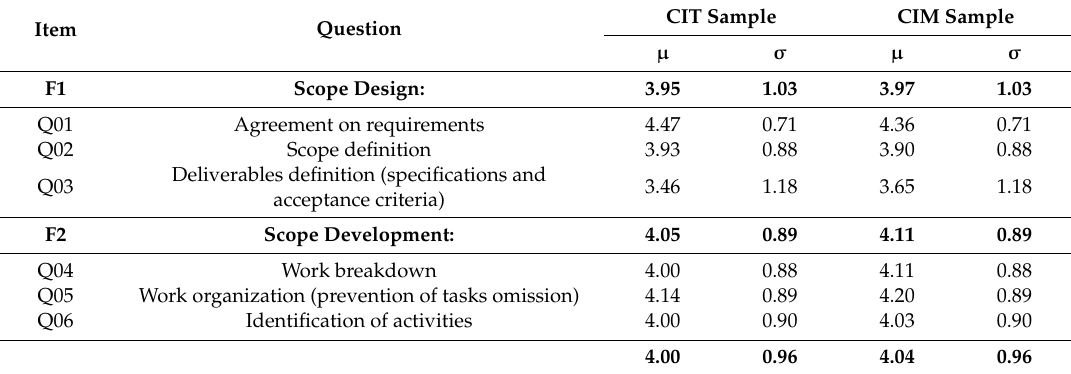
Table 10. Answers to questions related to scope design and development (1–5 scale).